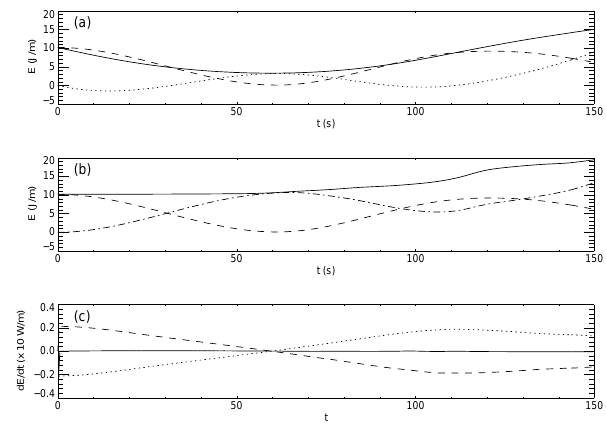
Fig. 15. Energetics for deep seiche case. (a) Dots: ¯ E kp . Dashed: ¯ E a . Solid: their sum. (b) Dots: (c) Dots: d( ¯ E kp + ¯ E a )/dt . Dashed: 1p s M . Solid: their sum.